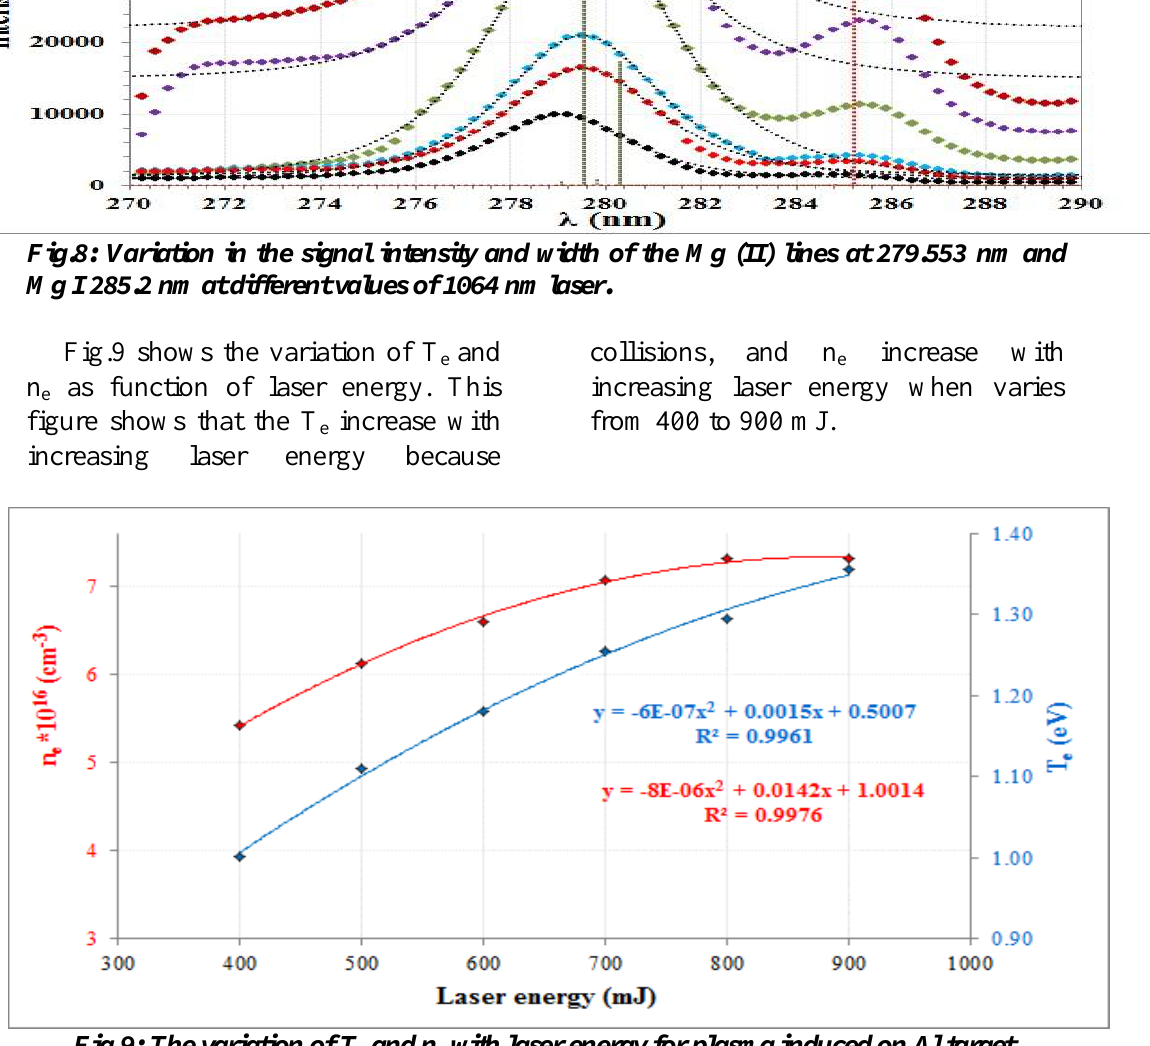
and n with laser energy for plasma induced on Al e e